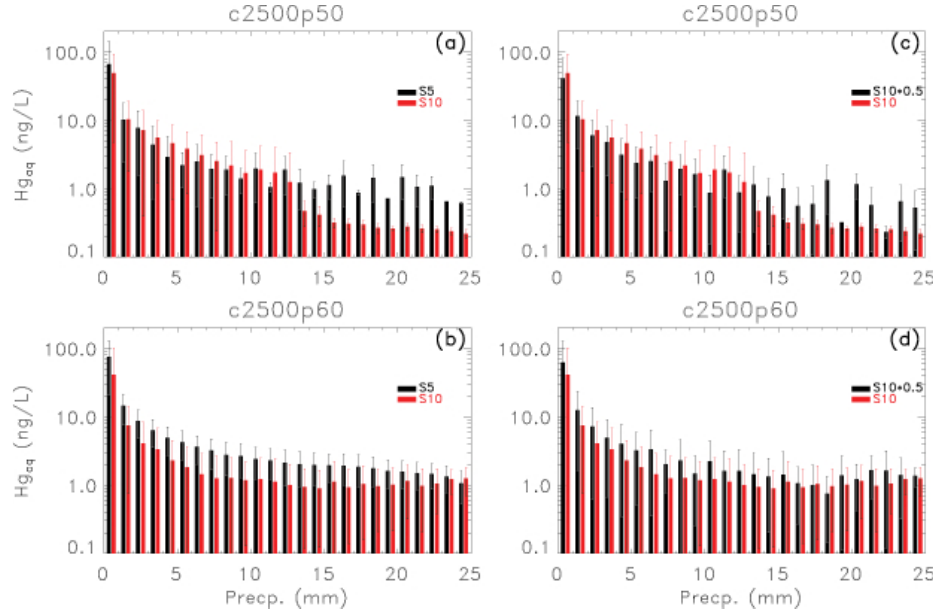
Fig. 8. Mercury concentration as a function of accumulated rainfall for (a) and (c) , CAPE in c2500 and PW in p50; (b) and (d) , CAPE in c2500 and PW in p60. For (a) and (b) SHEAR categories s5 (black) and s10 (red). For (c) and (d) SHEAR categories s10 (red) and divided by 2 (black).